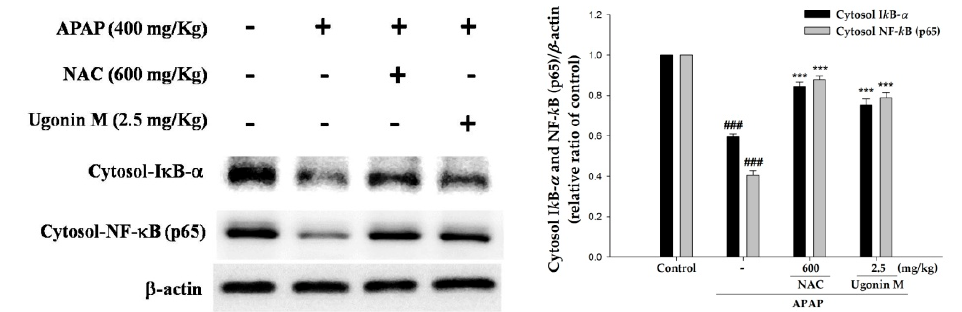
Figure 8. Effects of Ugonin M on APAP-induced cytosolic inhibitory κ B- α (I κ B- α ) and nuclear factor-kappa B (NF- κ B) expression in liver tissue. Data are expressed as M ± SD; n = 3.